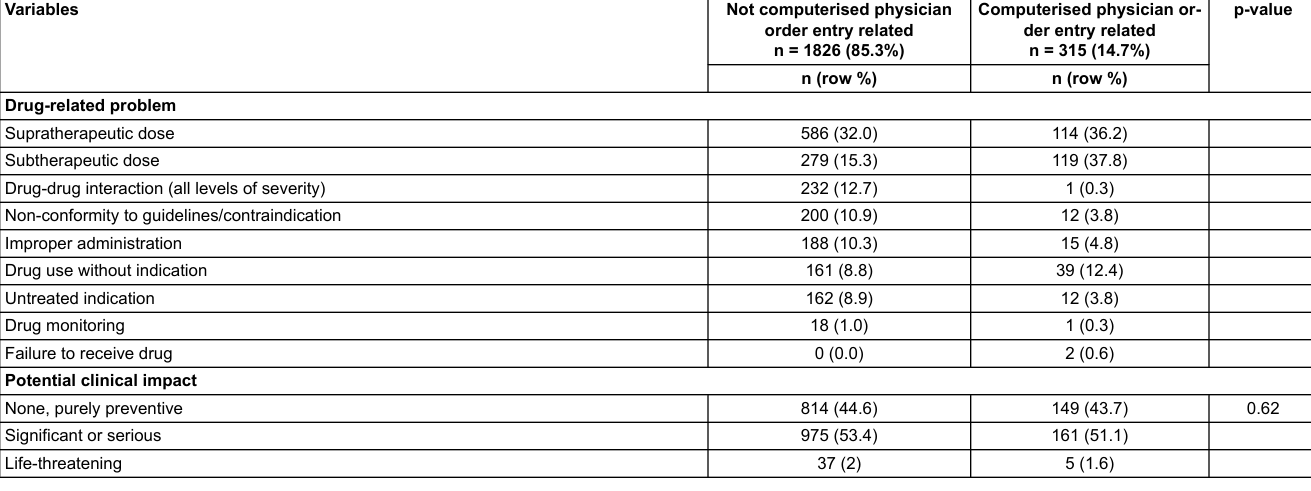
Table 3: Association between computerised physician order entry involvement in prescription errors and variable (univariate analysis).